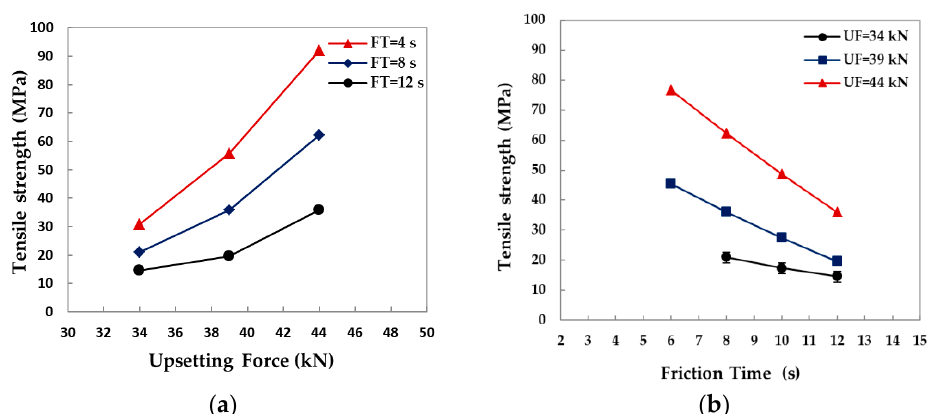
Figure 6. Effects of the upsetting force and friction time on the tensile strength of friction welds. ( a ) UF on TS, (b) FT on TS.